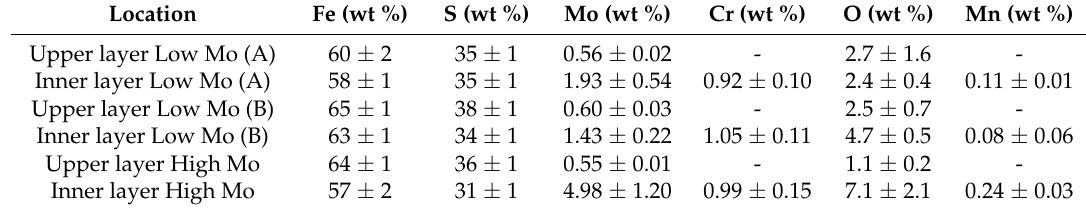
Table 2. Mean compositions of the upper and inner corrosion layer of the low Mo (A), low Mo (B), and high Mo materials, measured with electron probe micro-analyzer (EPMA).